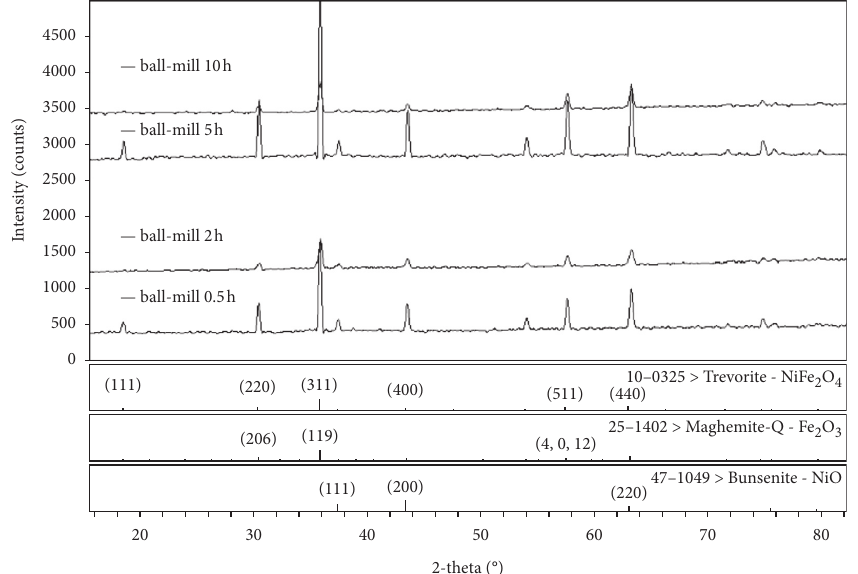
Figure 11: XRD diffraction pattern of the milled powders after sintered 1340 ° C for